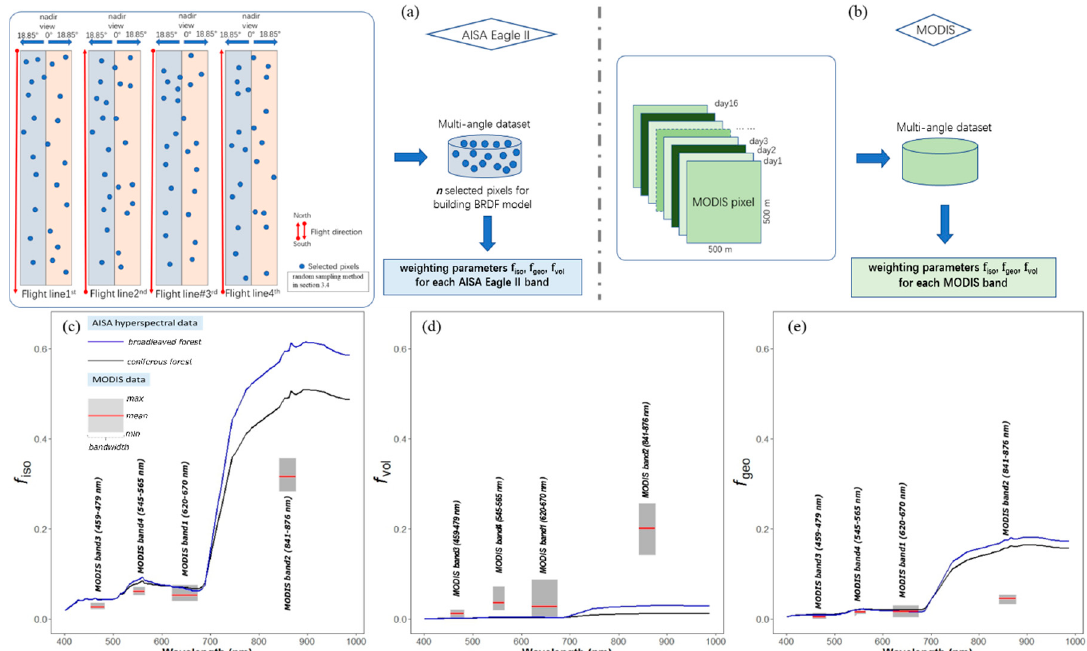
Figure 12. Di ff erent sampling strategies of a multi-angle dataset for retrieval the kernel-based weighting parameters of Airborne Imaging Spectrometer for Applications (AISA) Eagle II ( a ) and Moderate Resolution Imaging Spectroradiometer (MODIS) ( b ) data. The comparison of the three BRDF model weighting parameters f iso ( c ), f vol ( d ), and f geo ( e ) between AISA Eagle II and MODIS, respectively.